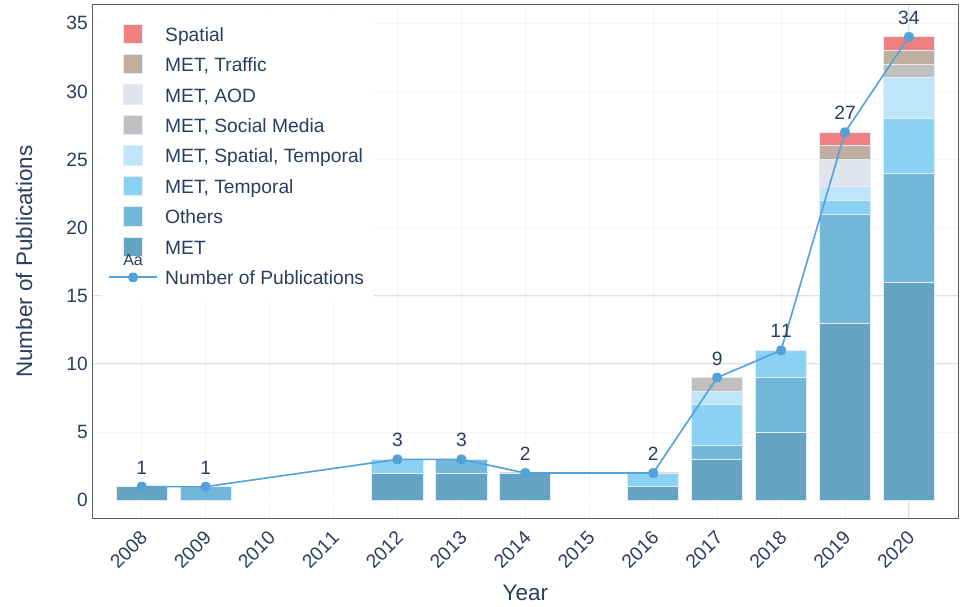
Figure 3. The distribution of the dataset combinations throughout the